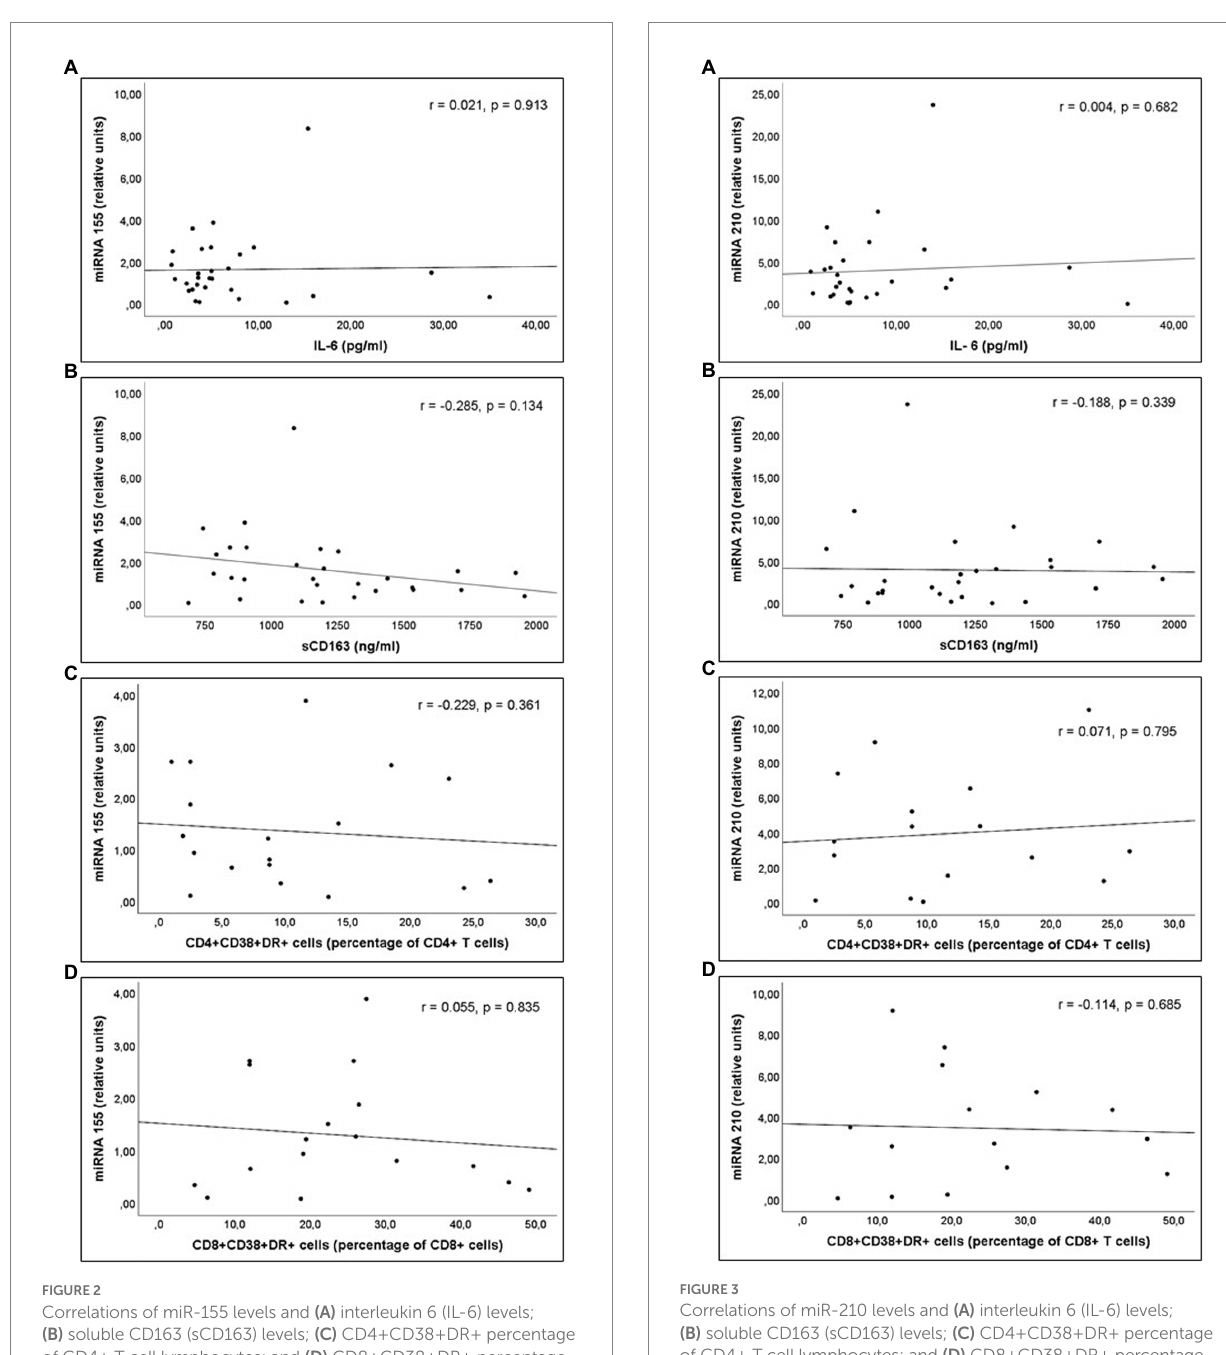
FIGURE 3 Correlations of miR-210 levels and (A) interleukin 6 (IL-6) levels; (B) soluble CD163 (sCD163) levels; (C) CD4+CD38+DR+ percentage of CD4+ T cell lymphocytes; and (D) CD8+CD38+DR+ percentage of CD8+ T cell lymphocytes count, in untreated people living with